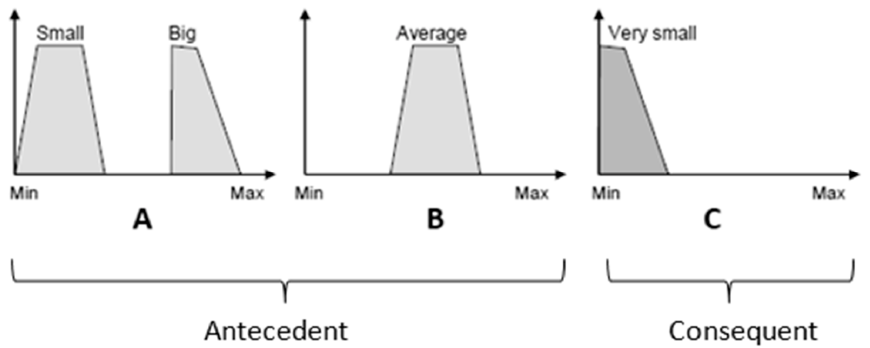
Figure 3. Example of graphical If-Then, fuzzy